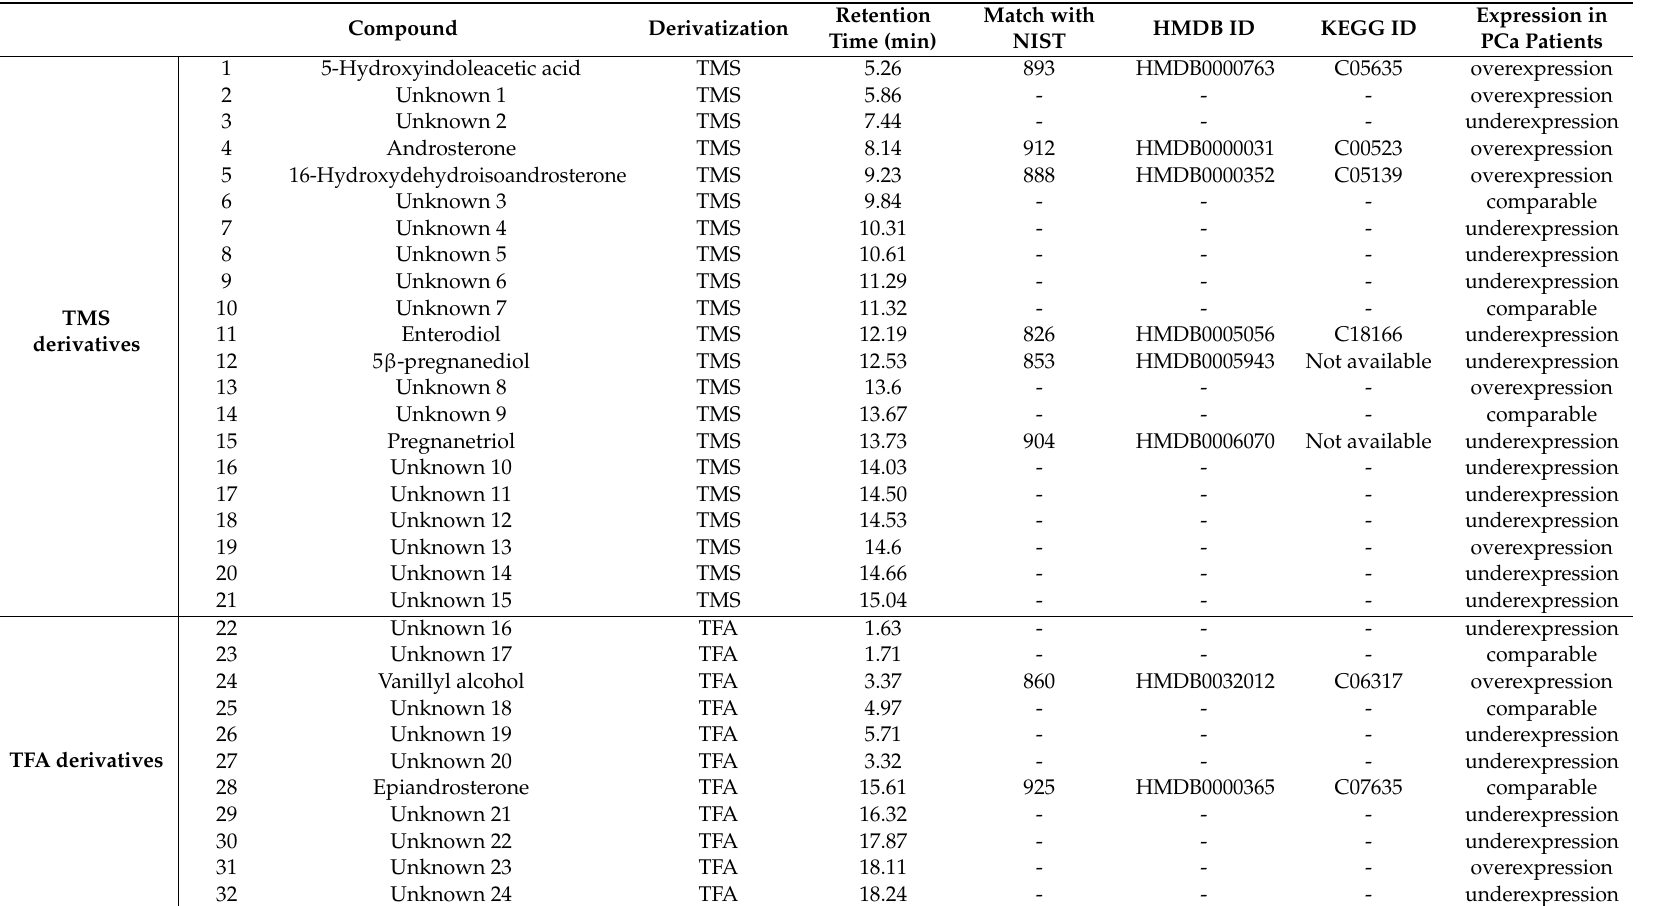
Table 1. List of the 32 selected metabolites. The kind of derivatization, retention time, and expression in prostate cancer (PCa)-a ff ected individuals are reported. Moreover, metabolites with a putative identification are accompanied by the match score with NIST library and the relative identification (ID) number in the Human Metabolome Database (HMDB) and the Kyoto Encyclopedia of Genes and Genomes (KEGG) database. The mass spectra of the 32 metabolites are reported in Supplementary Materials—Figure